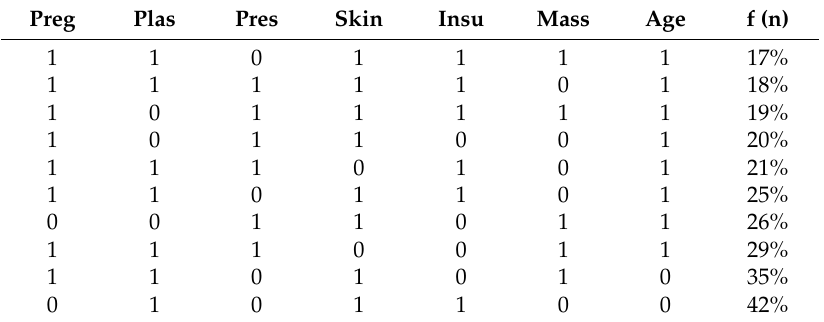
Table 16. Swapping and Ranking of chromosome set based on Recalculated Fitness function after Crossover.